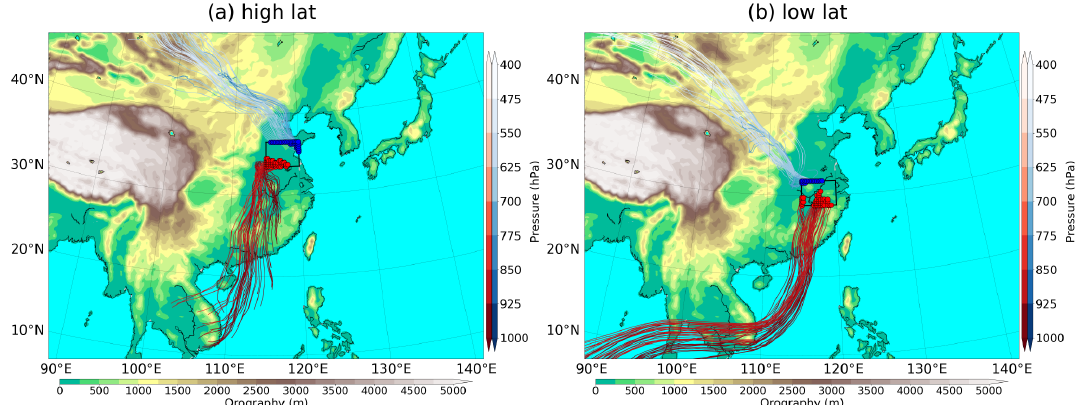
Figure 17. Warm (red) and cool (blue) Lagrangian trajectories for the Mei Yu stage. As in Fig. 11c, but for (a) high-lat years and (b) low-lat years. The selection domain is constructed as in Fig. 11, with mean frontal latitudes equal to (a) 35 and (b) 30.25 ◦